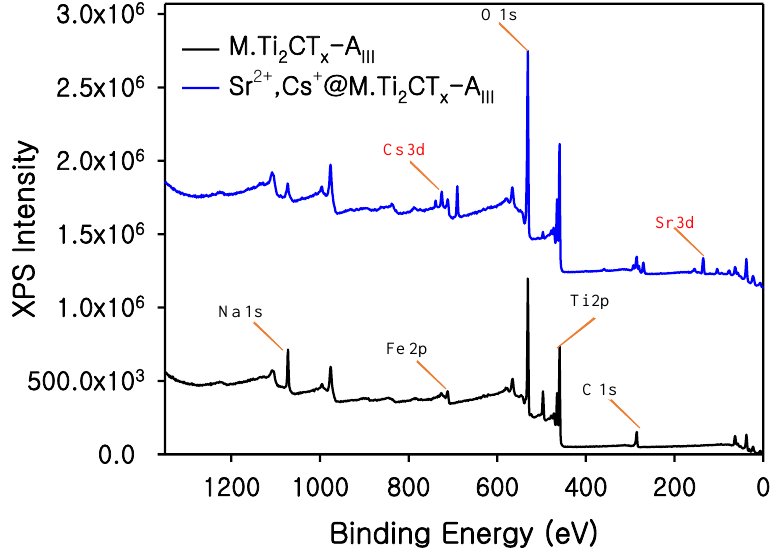
Figure 3. X-ray photoelectron spectroscopy of M.Ti 2 CT x -A III before and after adsorption of radionu- clides.